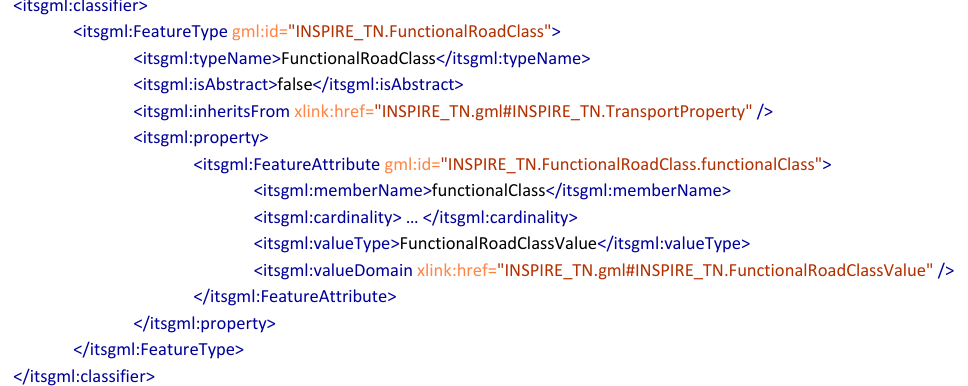
Figure 9. INSPIRE SpeedLimit and FunctionalRoadClass.